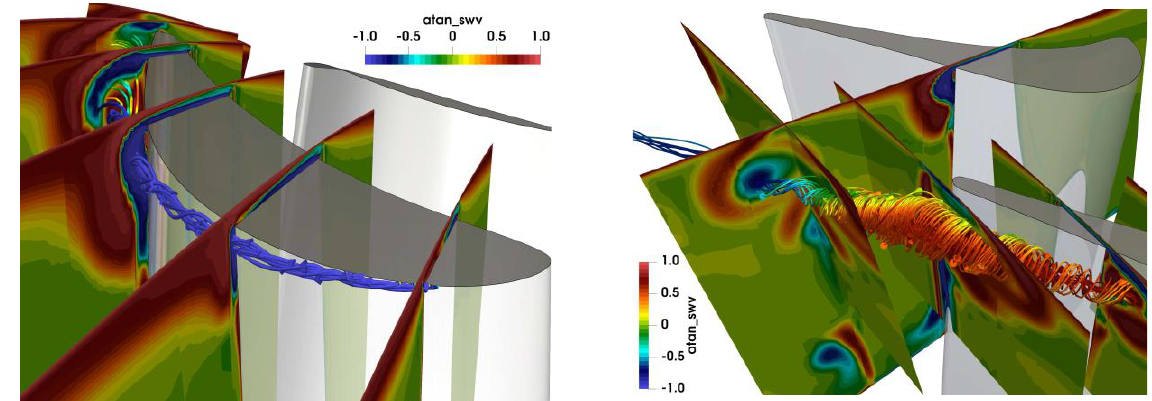
Figure 7. Streamlines in the tip region (not colored by SWV).